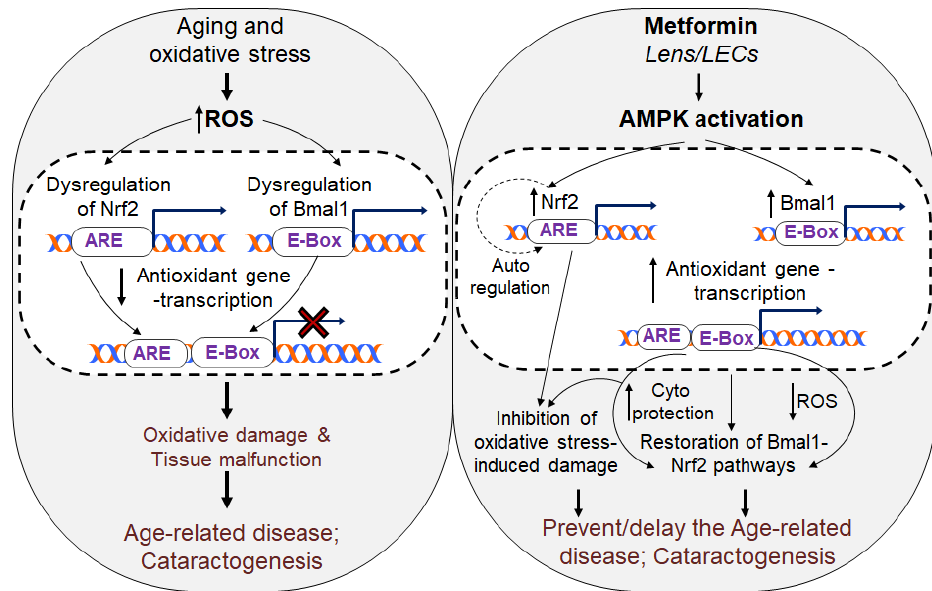
Figure 17. Diagrammatic elucidation of the molecular mechanism of Metformin-mediated restoration of dysregulated Bmal1/Nrf2-dependent antioxidant protective pathway leading to cytoprotec- tion and cataract prevention in response to Aging/oxidative stress. Oxidative stress/aging causes increase in ROS accumulation-driven dysregulation of AMPK/Bmal1/Nrf2 pathways. Our results demonstrated that organic cation transporter (OCTs) present in LECs and upregulated by Metfor- min treatment. This phenomenon evoked by Metformin can facilitate its increased cellular abun- dance, and thereby, promoting cellular health through the regulatory interactions of ronments during aging and oxidative stresses. We conclude that aging/oxidative stress induced in- jurious signaling pathways due to deterioration of antioxidant defense mechanism(s) during aging that underlies age-associated diseases; Metformin holds a great promise for combating aging-or ox- idative-related pathobiology.